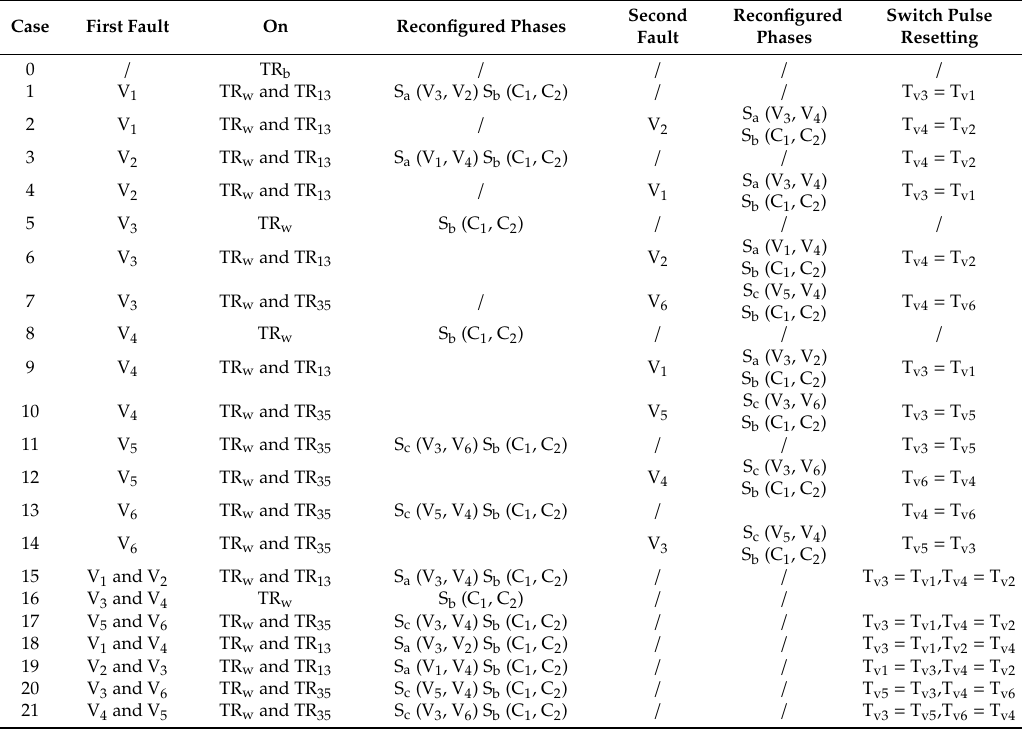
Table 1. Secondary reconfigurable inverter switching status.